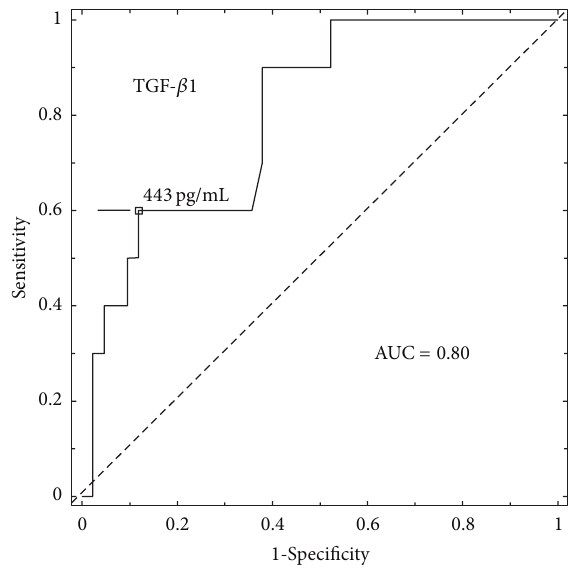
Figure 1: AUC ROC for serum TGF- 𝛽